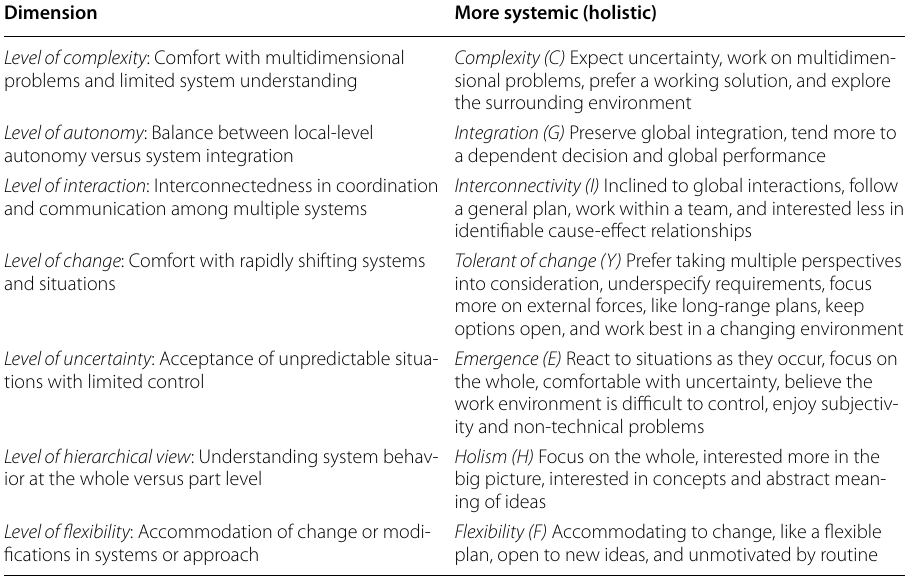
Table 2 The operational definition of the ST skills instrument (Jaradat et al. 2017 ) Dimension More systemic